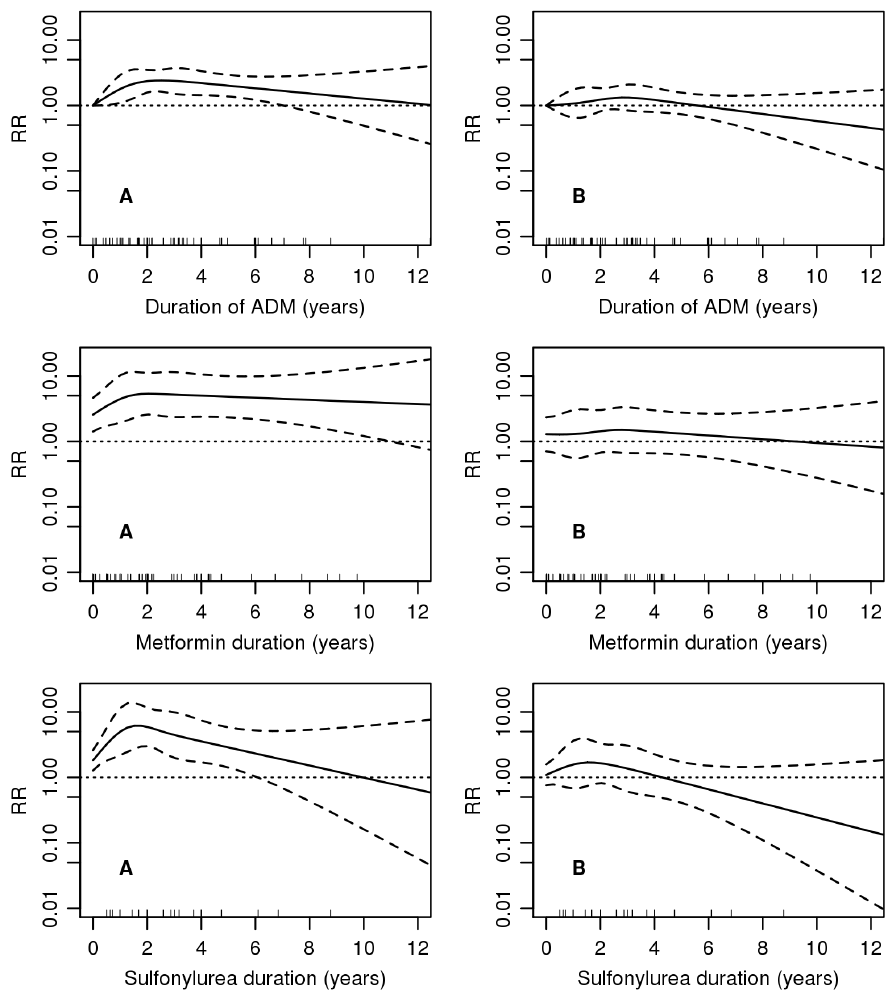
Figure 1. Cancer incidence rate ratio for ADM users vs. non-users. Results from spline models A - with no adjustment, B - adjusted for age, gender, calendar time, BMI, and smoking status (including interactions of age and gender; age and BMI). For metformin and sulfonylurea, allocation of RR . 1 at the initiation refers to the effect of being already treated with other anti-diabetic medicines. Thick dashed lines indicate 95% CIs, thin horizontal dotted line is a reference line for no effect, tick marks along the base of plot for cancers occurred among users.